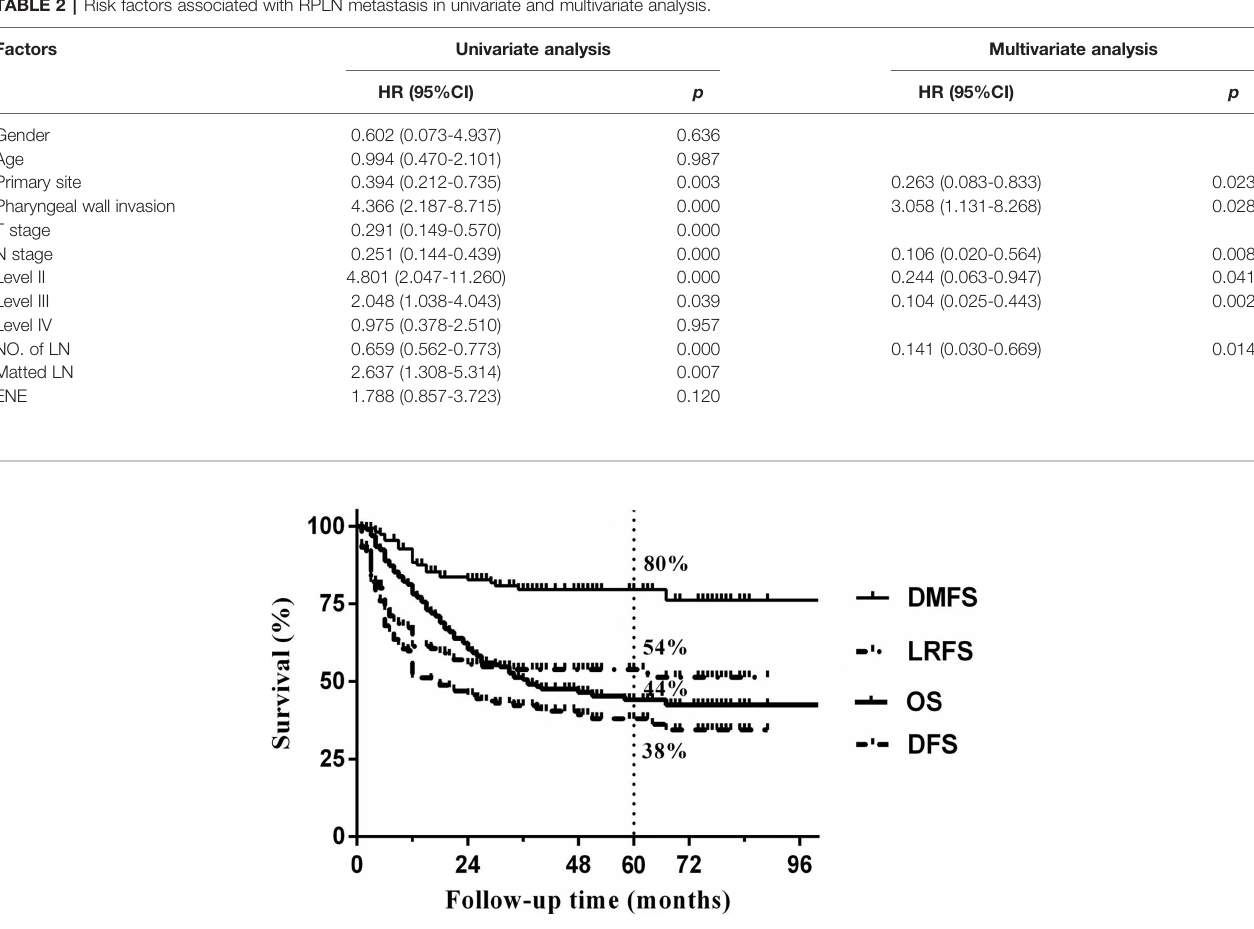
FIGURE 2 | Survival curves in the whole